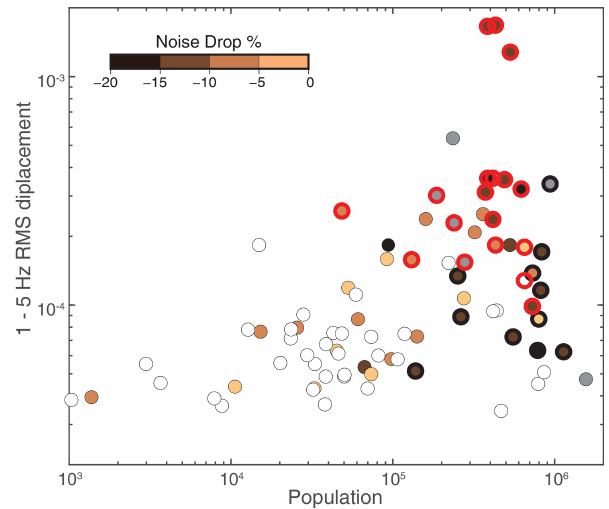
Figure 2. Noise rms level and drop with respect to municipality population. The outlined symbols denote stations located in capital cities; the ones in red are in Mexico City. The white circles corre- spond to stations where no weekly cycle was observed and the grey ones to stations where it was not possible to identify a drop in the noise